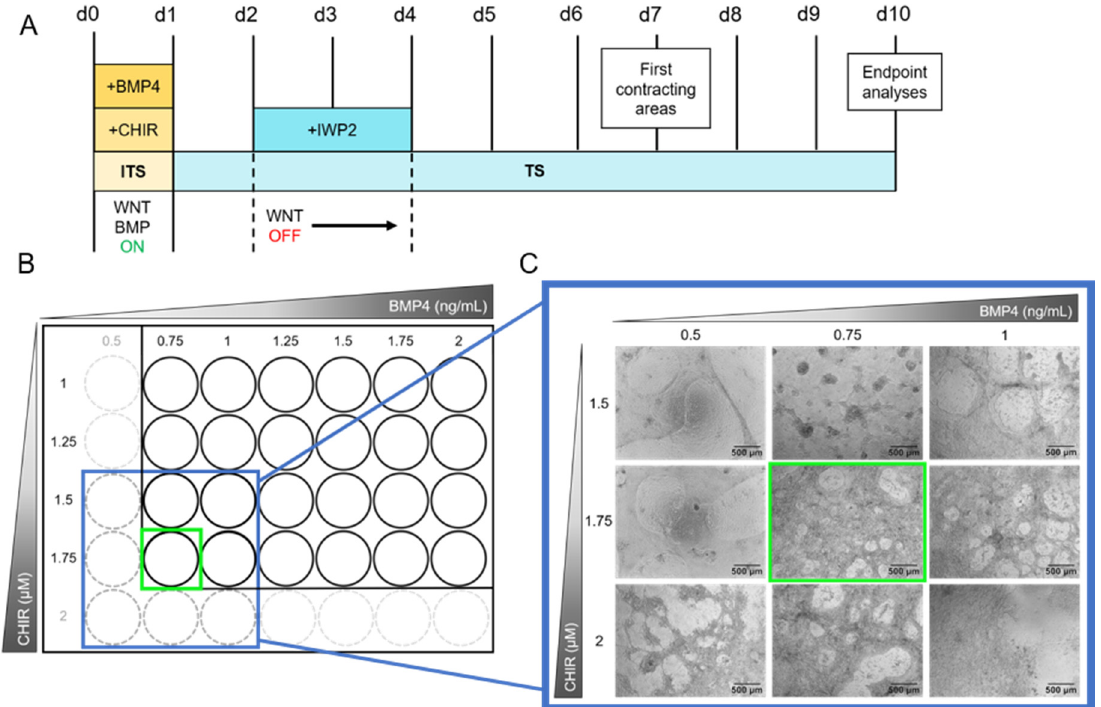
Figure 3. Schematic depiction of the cardiomyocyte differentiation protocol and range-finding experiment of CHIR99021 (CHIR) and bone morphogenetic protein 4 (BMP4) concentrations. ( A ): The protocol starts with the activation of the WNT and BMP signaling pathways by adding CHIR and BMP4, respectively, to the ITS medium. After 24 h, the ITS medium is changed to TS medium. On days 2 and 3 the WNT pathway is inhibited by supplementing TS medium with Inhibitor of WNT Production-2 (IWP2). From day 4 to 10 the medium is replaced every other day with TS medium devoid of pathway modulators. First beating cardiomyocytes are observable on day 7. Endpoint analyses are performed on day 10. For media compositions see Materials and Methods Section 3.2.2 and Supplementary Tables S1–S3. ( B ): The concentrations of CHIR and BMP4 have to be assessed for every hiPSC line individually. Therefore, a grid of 1 to 1.75 µ M CHIR and 0.75 to 2 ng/mL BMP4 in increments of 0.25 µ M and ng/mL, respectively, was applied using the protocol shown in ( A ), seeding 5 × 10 5 cells/Matrigel (MG)-coated 24-well in 1.5 mL medium. In case the first results showed an optimal concentration combination at the edge of the grid (green square in ( B )), the grid was extended framing the optimal concentration (blue square in ( B )) and tested again. ( C ): Exemplary images of the grid testing for iPS11 cells. The grid was extended to 2 µ M CHIR and 0.5 ng/mL BMP4 as shown in ( B ). Concentrations of interest were tested in triplicates seeding 2.75 × 10 5 cells/MG-coated 48-well following the protocol shown in ( A ) (see Section 3.2.4). Exemplary images were taken on day